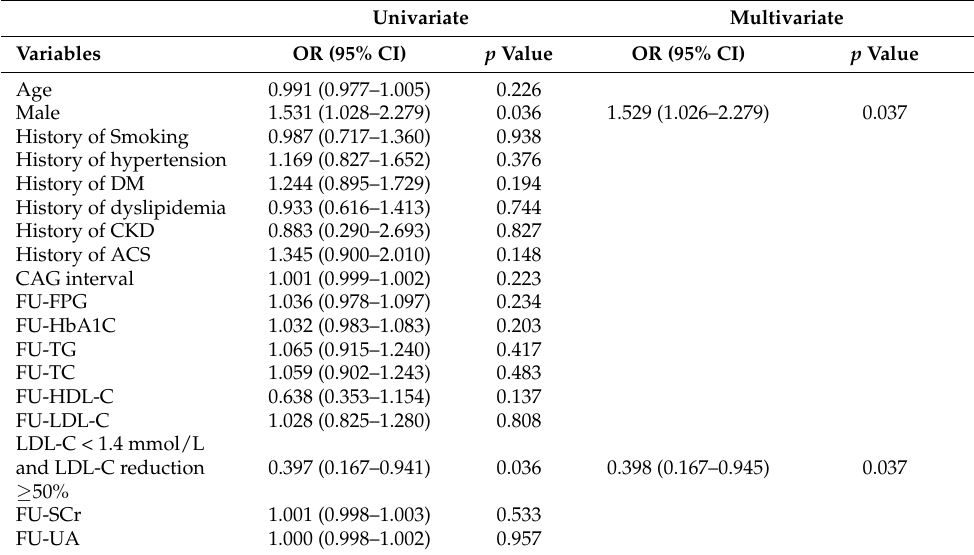
Table 3. Logistic regression analysis for the presence of NTL plaque